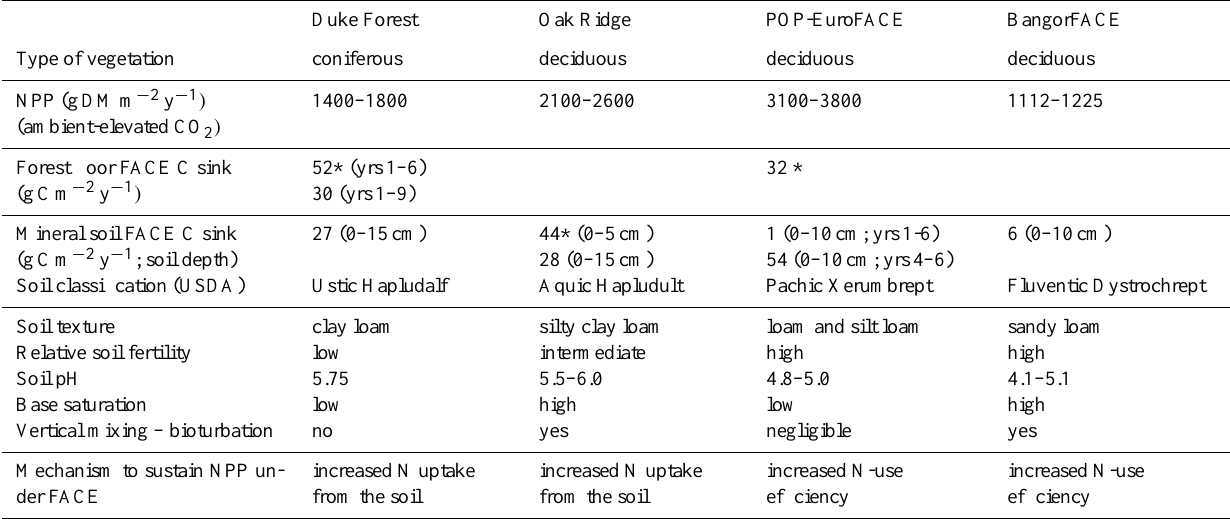
Table 5. Additional C sinks in the forest floor – soil systems and major vegetation and soil characteristics of selected forest FACE experiments (Scarascia-Mugnozza et al., 2006; Schlesinger et al., 2006; Norby et al., 2006; Norby et al., 2005; Finzi et al., 2007; Hoosbeek and Scarascia- Mugnozza, 2009; Lichter et al., 2008). Duke Forest Oak Ridge POP-EuroFACE